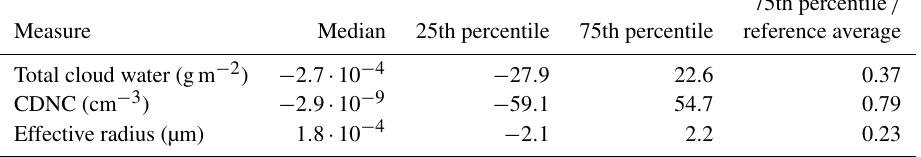
Table E1. Statistics of the cloud property differences (reference minus No-ALWC, ICA) over the Ivory Coast (7.5–3 ◦ W, 4–10 ◦ N) with respect to the time period 2 July 15:00UTC to 3 July 15:00UTC, including the median difference, the 25th and 75th percentile of the differences, and the ratio of the 75th percentile to the reference average. The CDNC and the effective radius refer to the median in the lowest 1500ma.g.l.